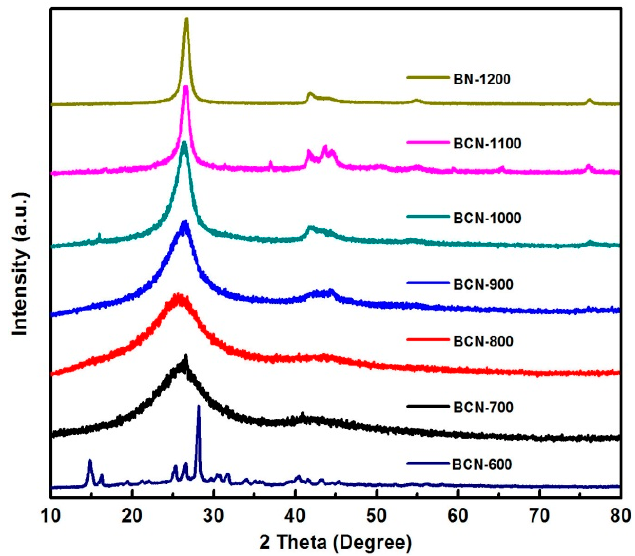
Figure 2. XRD pattern of BCN-600, BCN-700, BCN-800, BCN-900, BCN-1000, BCN-1100, and BN-1200.